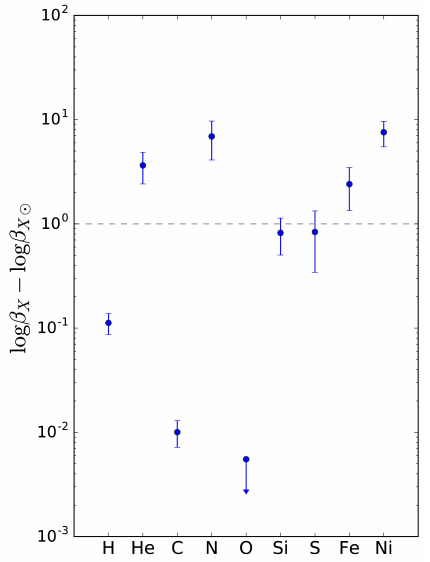
Figure 3. Chemical surface composition in solar units. Values for the solar abundances were adopted from Asplund et al. (2009) and Scott et al. (2015b,a) for elements heavier than